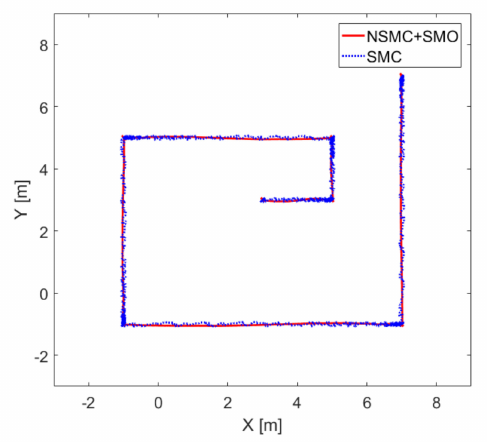
Figure 7. Quadrotor’s trajectory on the x − y plane.